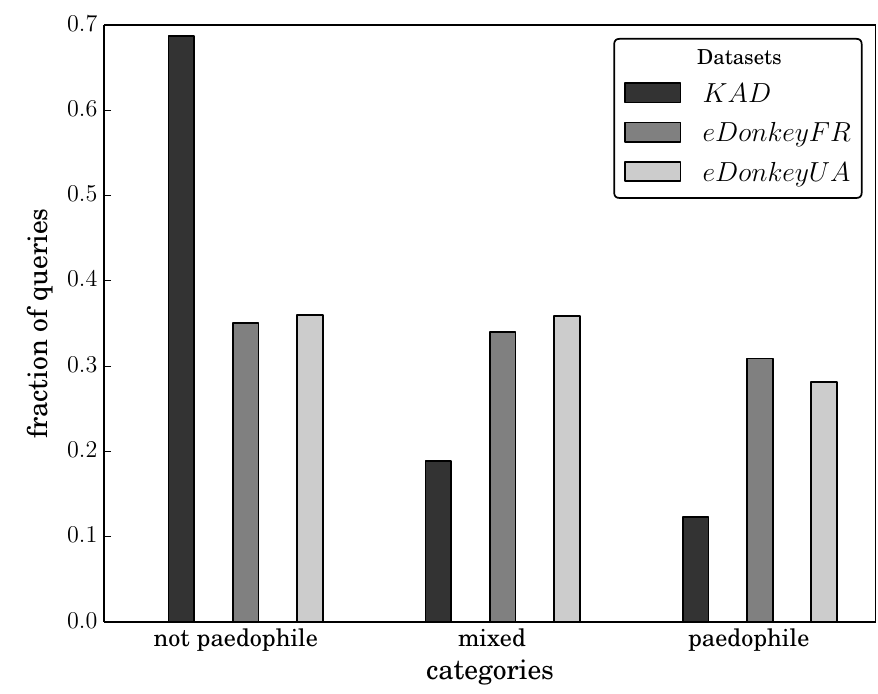
Figure 2. Ratio of keyword frequencies in eDonkey vs. KAD . Keywords are ranked in increasing order of paedophile coefficient . Points above the y = 1 horizontal line indicates keywords more frequent in the corresponding eDonkey dataset; below the line keywords are more frequent in KAD